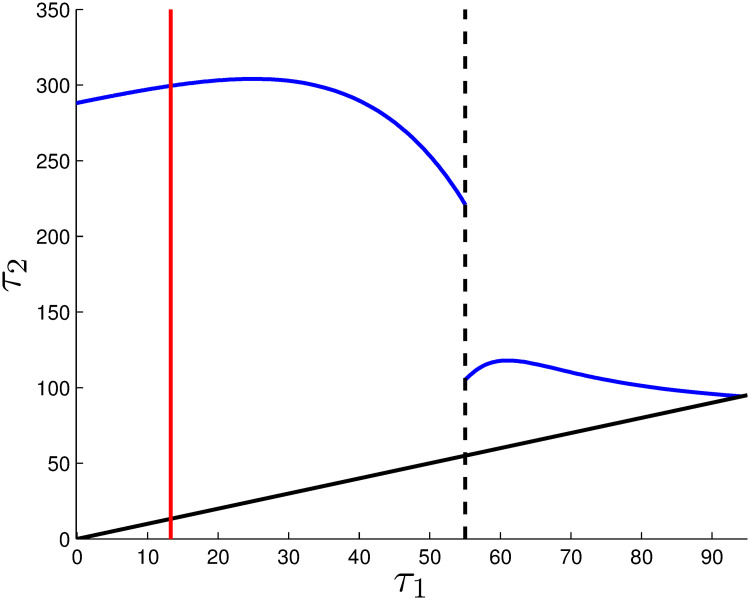
Fixed initial lockdown time τ1 and optimally chosen time τ2.For τ1 = 44 there exists a Skiba solution, i.e. there are two different solution paths which deliver the same objective value.